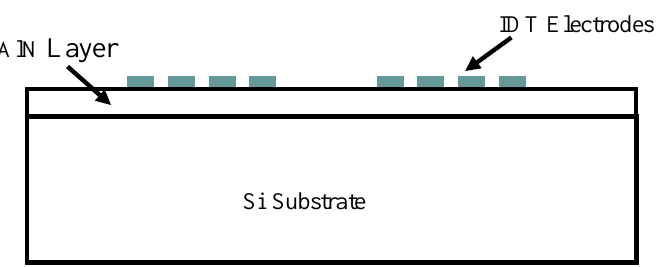
Figure 3. Schematic of the AlN/Si(111) SAW sensor.